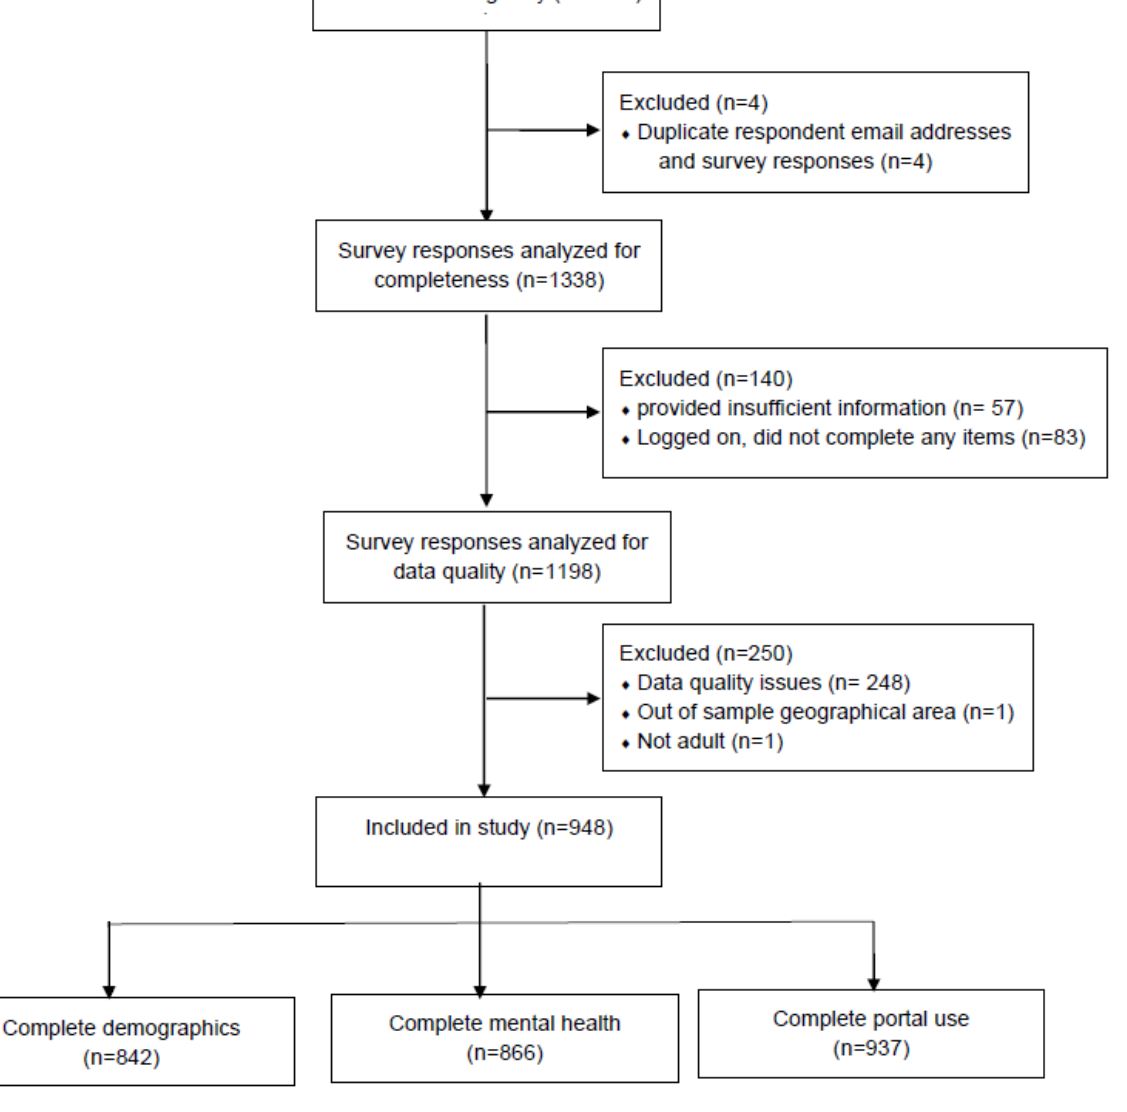
Figure 1. Flow diagram outlining number of eligible and responding participants to survey, as well as number of participants included in